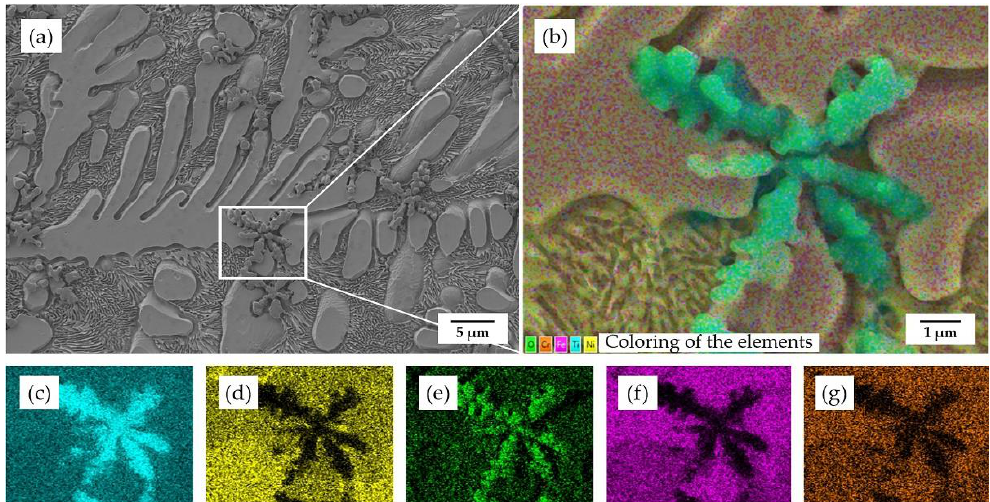
Figure 6. EDS regional scanning results of the coating after annealing under 450 °C: ( a ) original SEM morphology; ( b ) EDS composite image; ( c ) element Ti; ( d ) element Ni; ( e ) element O; ( f ) element Fe; ( g ) element Cr.